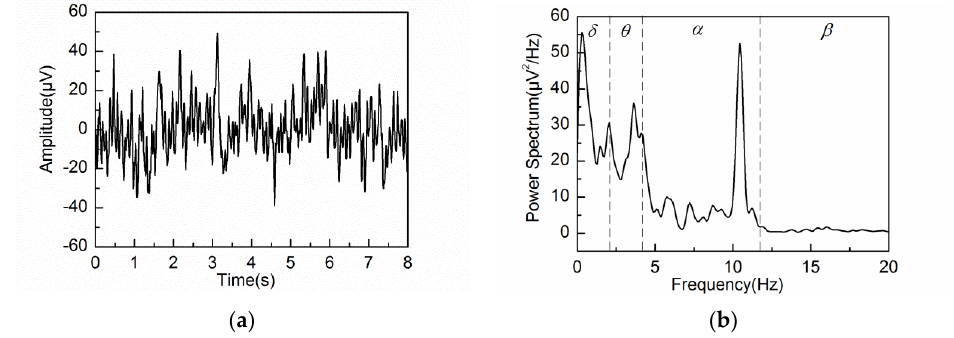
Figure 8. The real EEG signal and corresponding PSD under eyes-closed condition: ( a ) the real EEG signal under eyes-closed condition; ( b ) PSD of the real EEG signal under eyes-closed condition. Sensors 2018 , 18 , 697